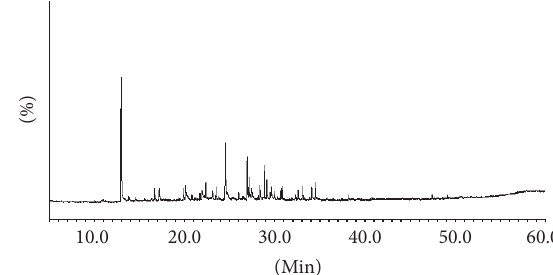
Figure 1: Gas chromatogram of PKO.